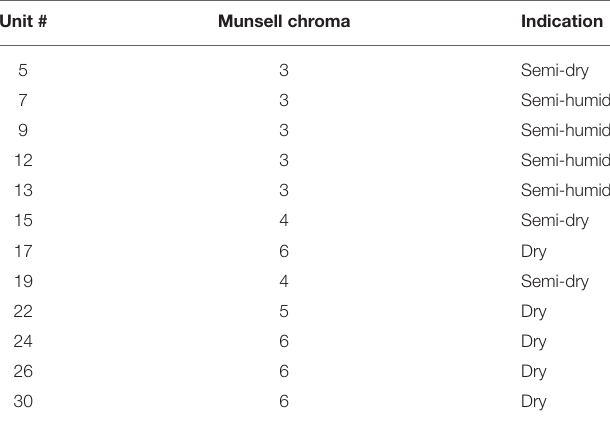
TABLE 1 | Soil chroma values and environmental indication for paleosol units exposed in the trench at LpM4. Unit